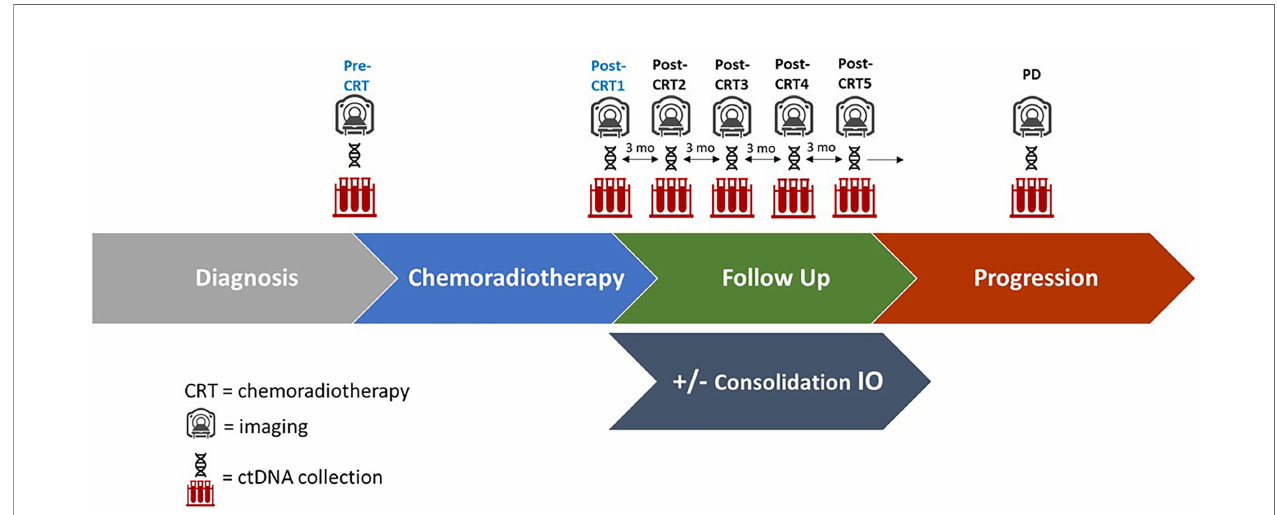
FIGURE 1 | Study Schema of ctDNA collection, imaging, and follow up. Plasma for ctDNA was collected at the time of chemoradiotherapy initiation (pre-CRT), at completion of chemoradiotherapy (post-CRT1), and at quarterly follow up appointments for 12 months (post-CRT2,3,4, and 5 respectively), as well as at the time of disease progression (PD) if it occurred. A subset of patients received consolidation immune checkpoint inhibitors (IO). Imaging was performed every three months following completion of